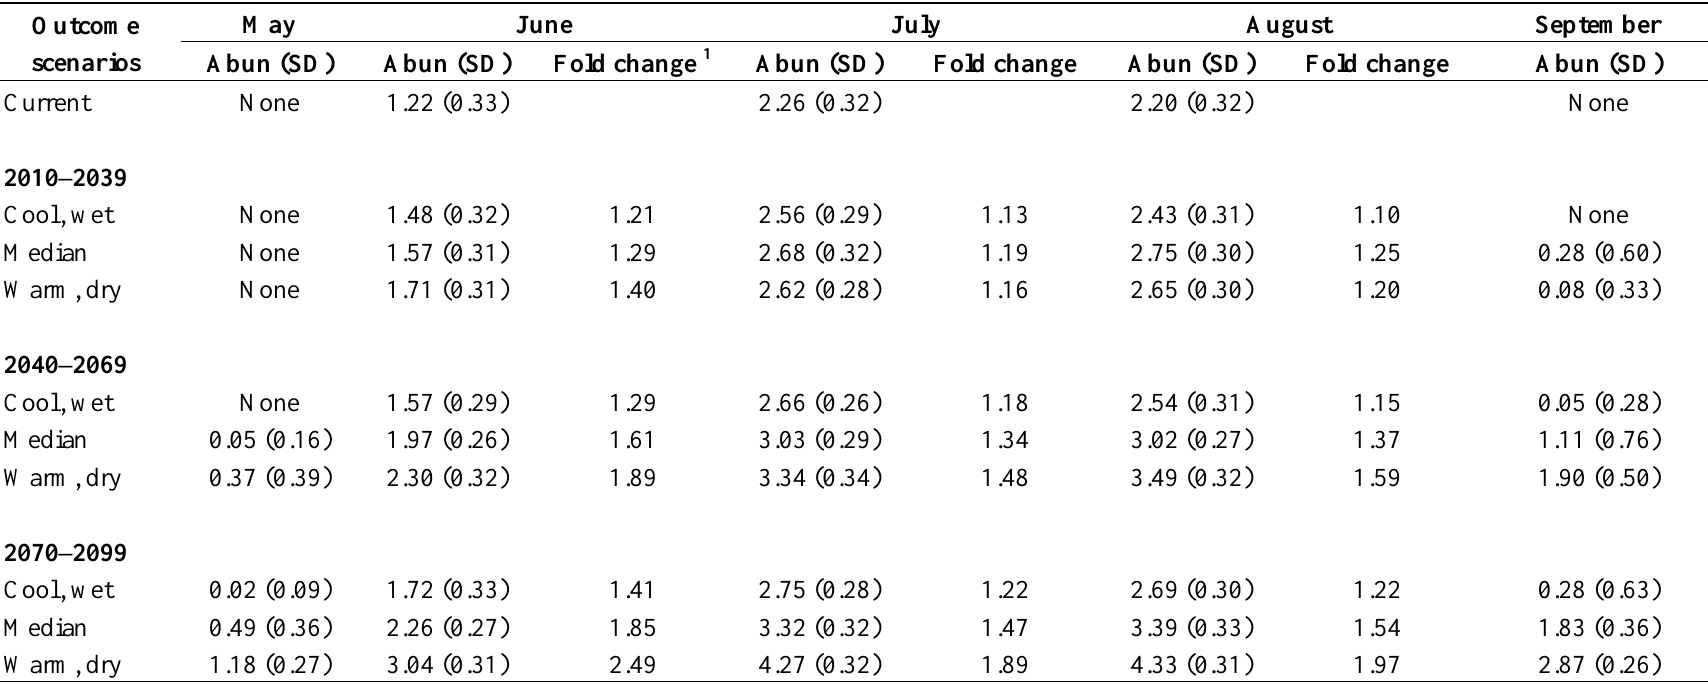
Table 5. Temporal distribution, mean abundance, log(y+1) transformed, and fold change of Cx. tarsalis abundance in the Canadian prairie ecozone for current and three future periods of selected outcome